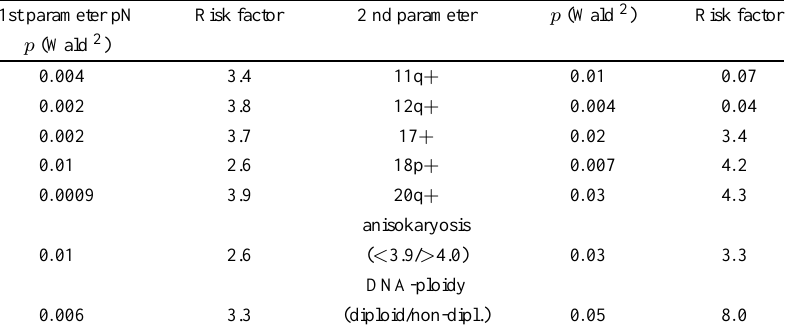
Results from Cox Proportional Hazard analyses. Each univariate significant parameter was inves- tigated bivariate with the lymph node status. Given are p-valus for the first and second parameter, respectively, and the risk